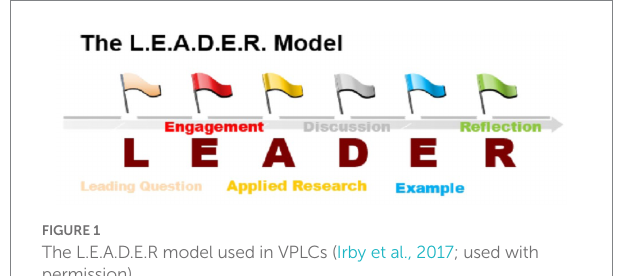
FIGURE 1 The L.E.A.D.E.R model used in VPLCs (Irby et al., 2017; used with